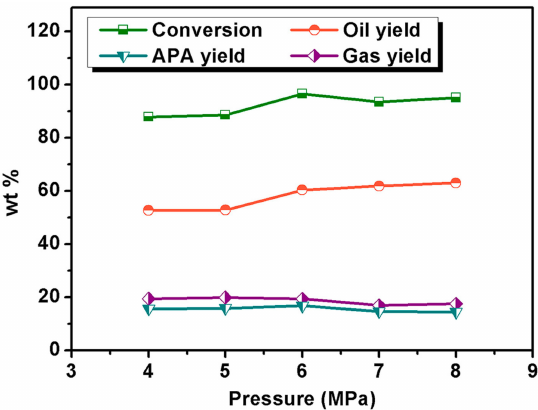
Figure 4. Results of the catalytic hydrogenation of Dahuangshan coal with Fe 3 O 4 nanoparticles in different initial H 2